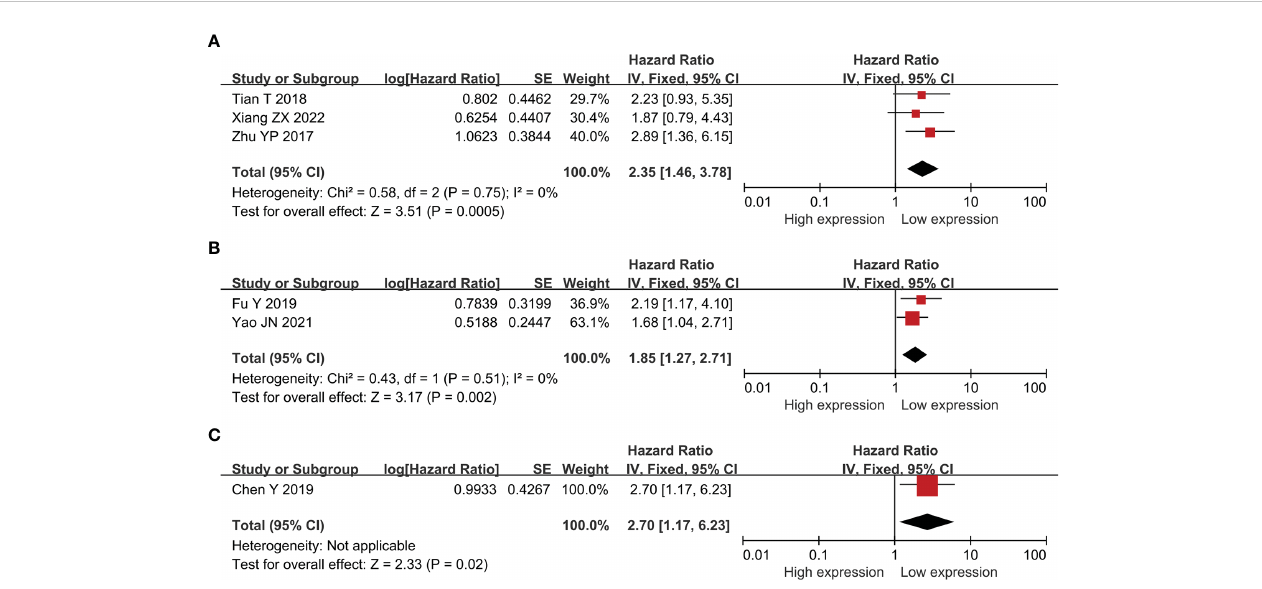
FIGURE 3 Forest plot showing the relationship between small nucleolar RNA host gene (SNHG) expression and progression-free survival (PFS) (A) ; disease-free survival (DFS) (B) ; and reference-free survival (RFS) in colorectal cancers (C) .